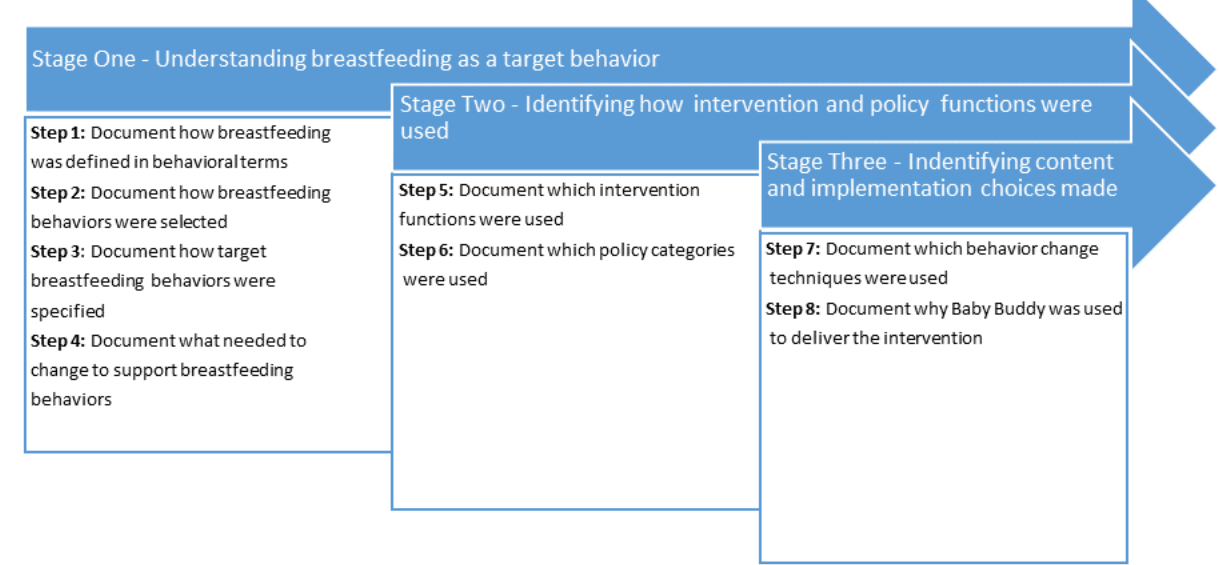
Figure 1. Process of applying the Behavior Change Wheel to the Baby Buddy